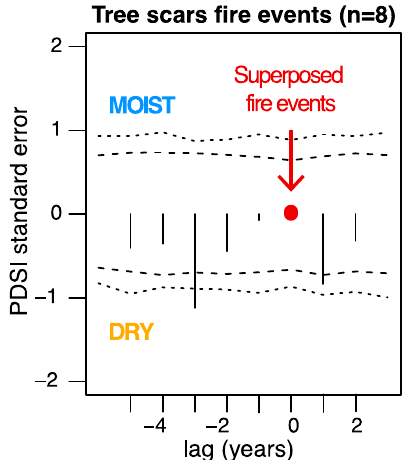
Figure 3. Fire–climate relationships. Superposed Epoch Analysis of moisture conditions derived from NADA PDSI for gridpoint 45.25ºN, − 93.25ºE (Cook et al. 2008, data available on ncdc.noaa.gov), with tree-ring-based fire events. The analysis was performed for the moisture condition 10 years before and after the fire events and bootstrapped 1000 times to calculate the confidence intervals at 95% (dashed lines) and 99% (dotted lines). All fire events correspond to the 8 fire events identified from the tree scars (1822, 1842, 1849, 1860, 1879, 1882, 1909, 1924